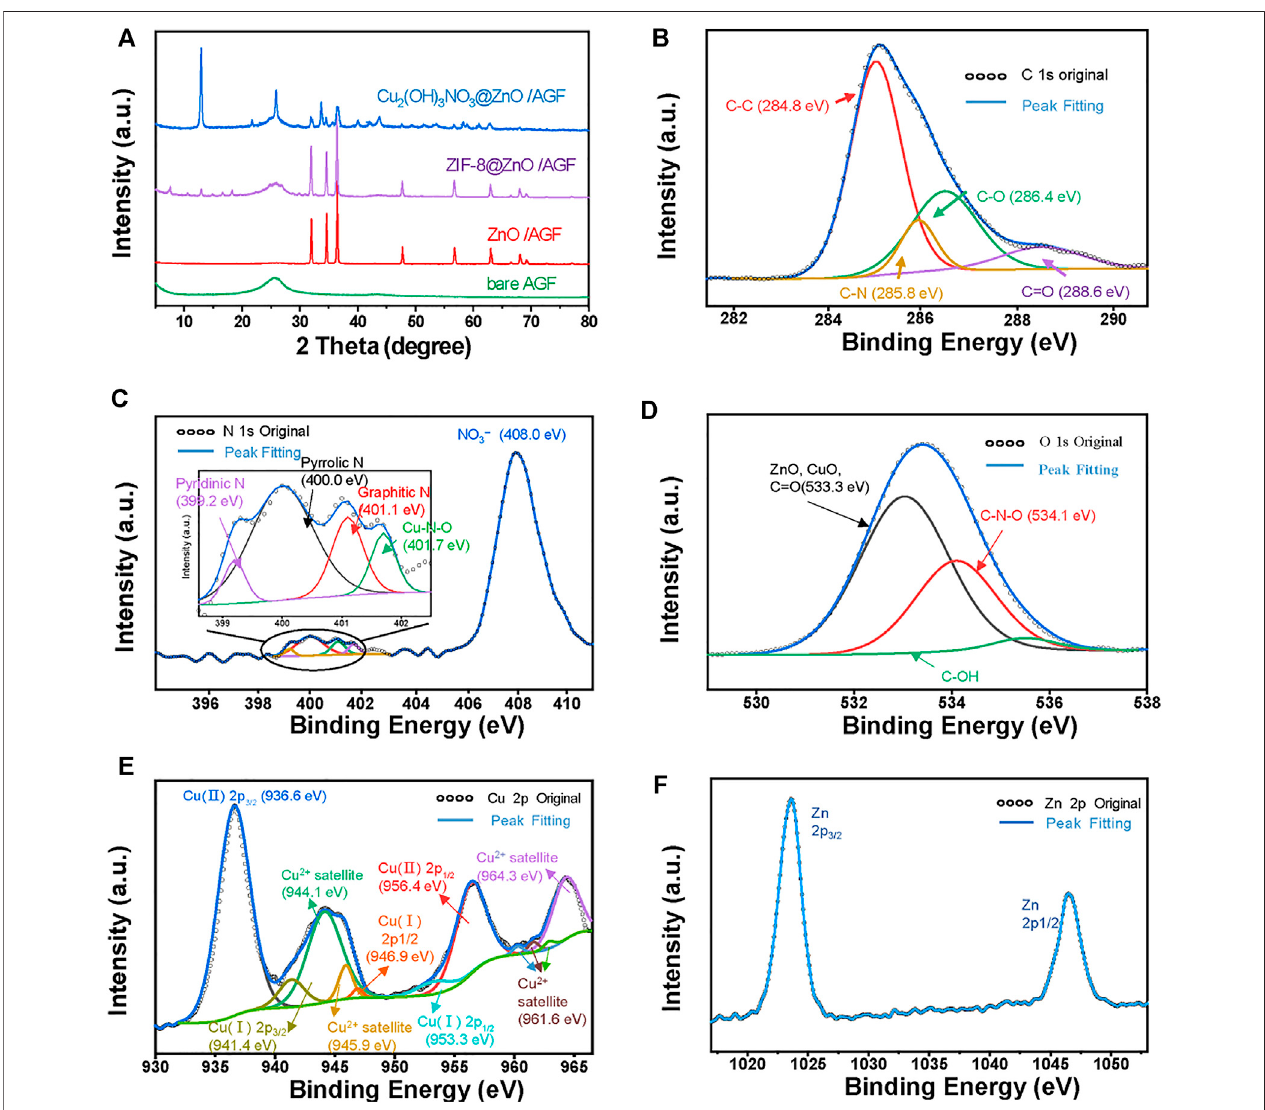
FIGURE3|(A) PXRDpatternsofAGF,ZnO/AGF,ZIF-8@ZnO/AGF,andCu 2 (OH) 3 NO 3 @ZnO/AGF.High-resolutionXPSspectraof (B) C1s, (C) N1s, (D) O1s, (E) Cu 2p, and (F) Zn 2p regions in Cu 2 (OH) 3 NO 3 @ZnO/AGF.